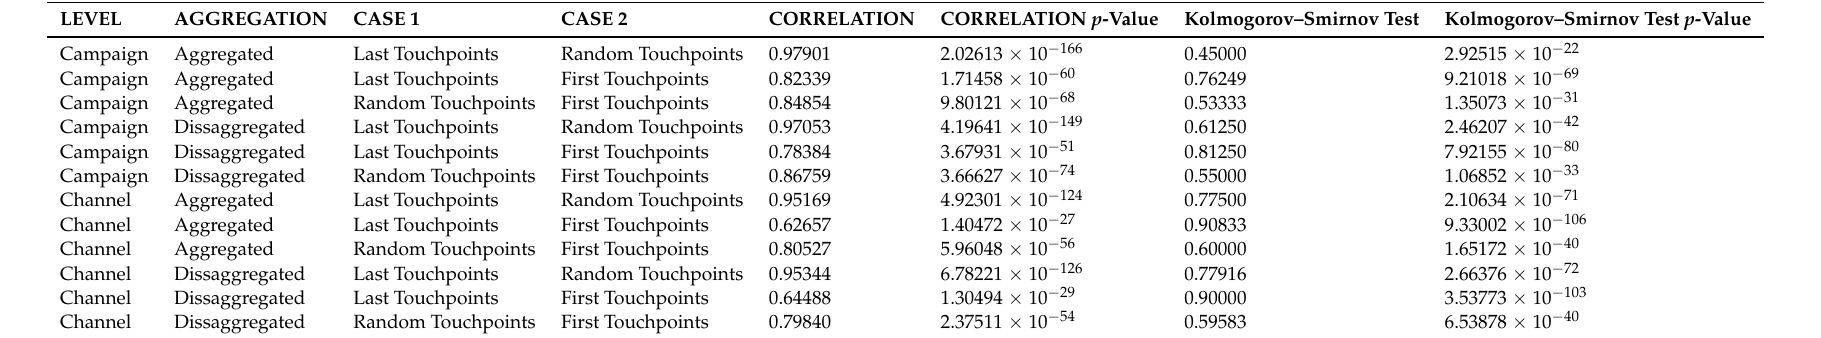
Table A3. This table shows the correlation and Kolmogorov–Smirnov test for Figure